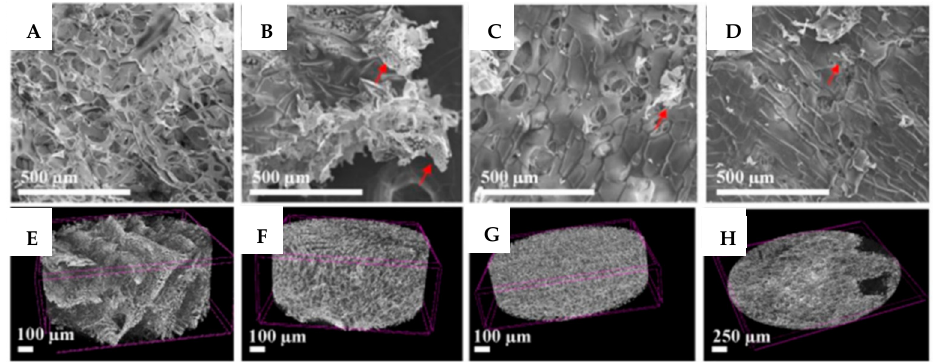
Figure 3. SEM and micro-CT images for the ( A , E ) reference CH/SHA matrix nanocomposite and modified with ( B , F ) 1 wt.%, ( C , G ) 5 wt.% and ( D , H ) 10 wt.% of 2D Ti 3 C 2 T x MXene lakes [69].